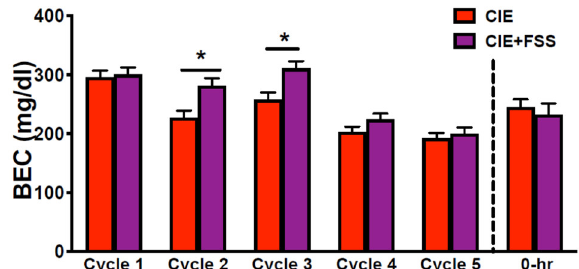
Figure 2. Blood ethanol concentrations (BEC) in mg/dL registered during each CIE exposure cycle and at the 0-h timepoint of tissue collection for the CIE and CIE + FSS groups. BECs were different between these groups only during exposure Cycles 2 and 3 (*).